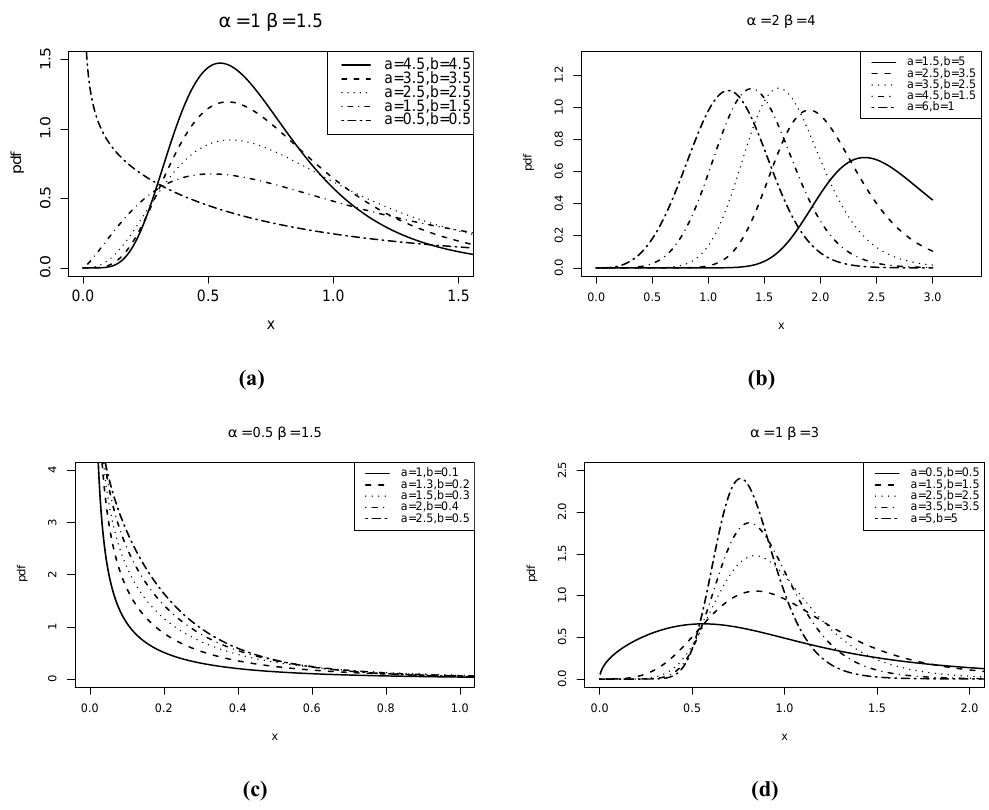
Figure 1 - Plots of the ELL pdf for some parameter